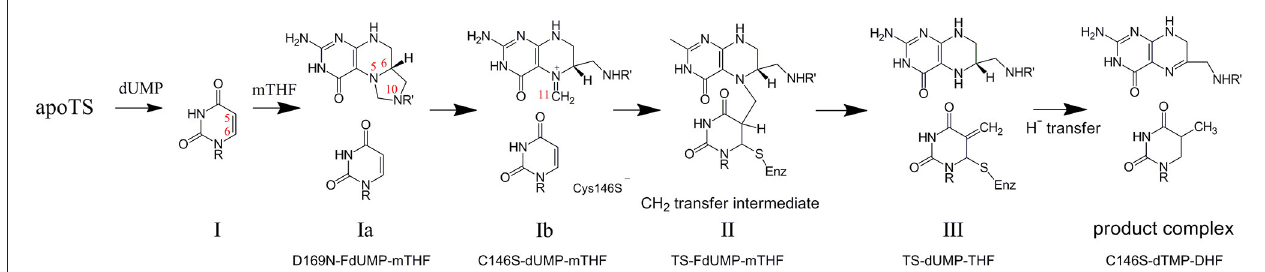
FIGURE 1 | Chemical mechanism of thymidylate synthase, as determined from kinetic studies on the E. coli enzyme. Atom numbering is shown in red numbers. The numbering of each intermediate is in accordance with Stroud and Finer-Moore (2003), and the specific ecTS variants and ligands used to mimic those intermediates are indicated. For step Ib, “Cys146S − ” indicates the location of residue 146 ( E. coli TS numbering) that is mutated to serine to trap at step Ib and that in the wild-type enzyme is the active site nucleophile that bonds to C6 of